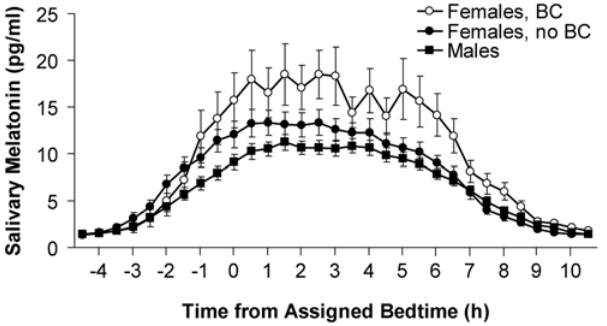
Figure 3. The mean melatonin profiles of females using (‘‘BC’’, n=16) or not using hormonal birth control (‘‘no BC’’, n=69) and males (n=85). The profiles are plotted with reference to assigned bedtime. Error bars represent SEMs.